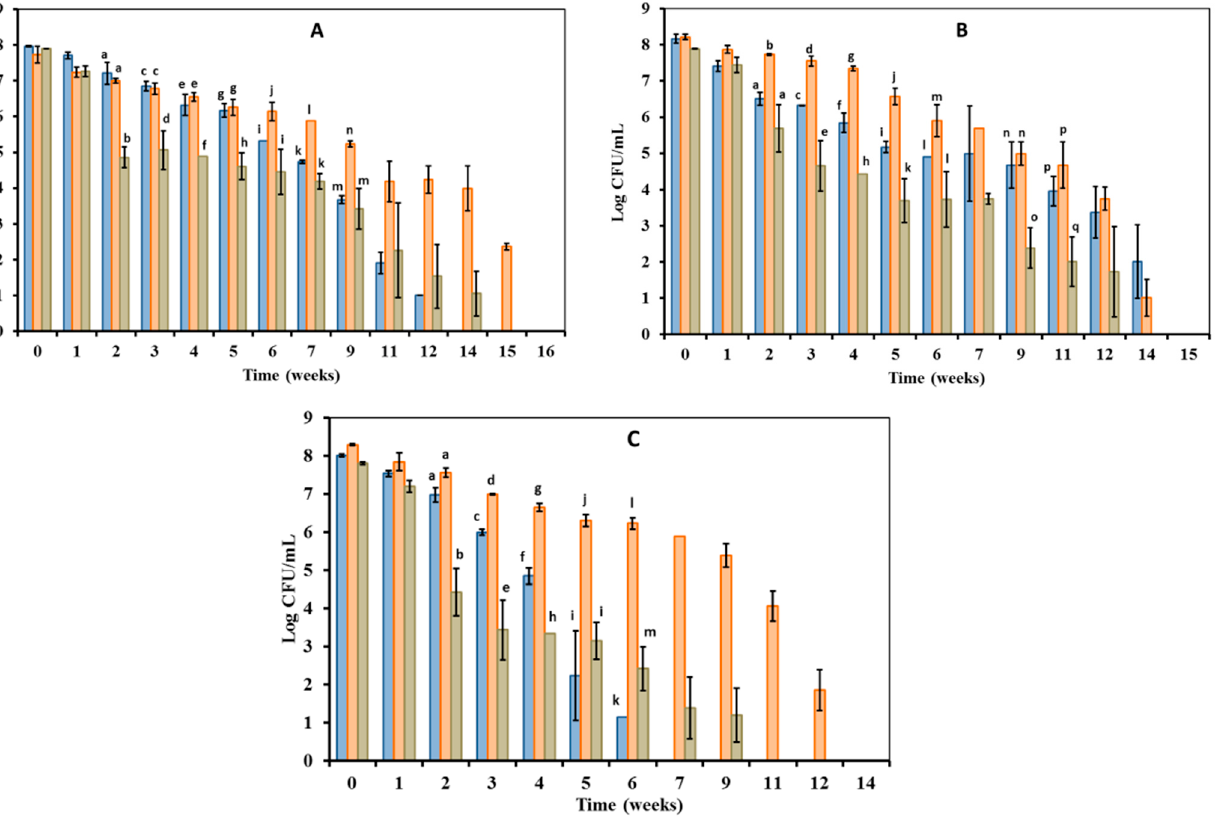
Figure 1. Culturable cell (VBC) numbers of Edwardsiella maintained under starvation conditions in FSLW microcosms at 7 °C (blue bars), 15 °C (orange bars) and 25 °C (green bars): ( A ) E. piscicida V12.1; ( B ) E. piscicida V57.2; ( C ) E. tarda V43.2. For each strain, values with different letters indicate significant differences at p < 0.05.